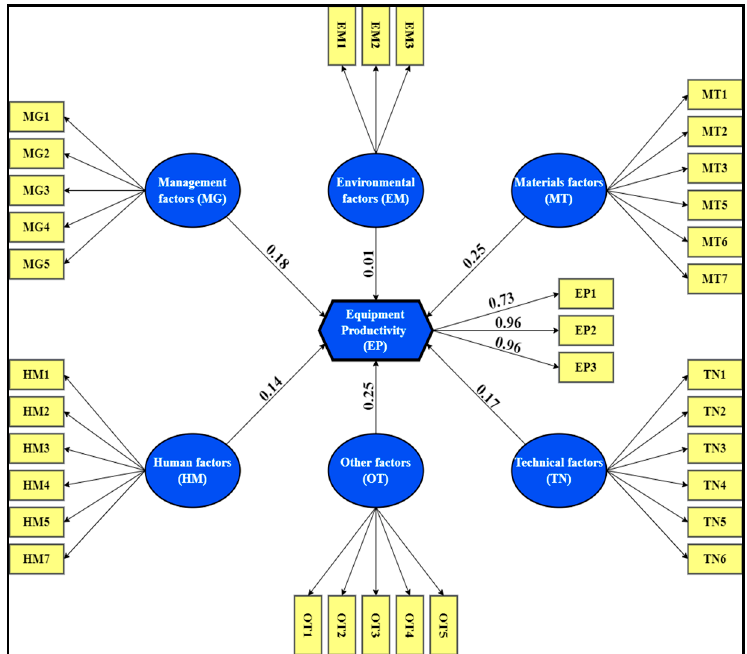
Figure 4. Validated framework using SEM. Table 5. Coefficients of standardization and R 2 values of the variables.